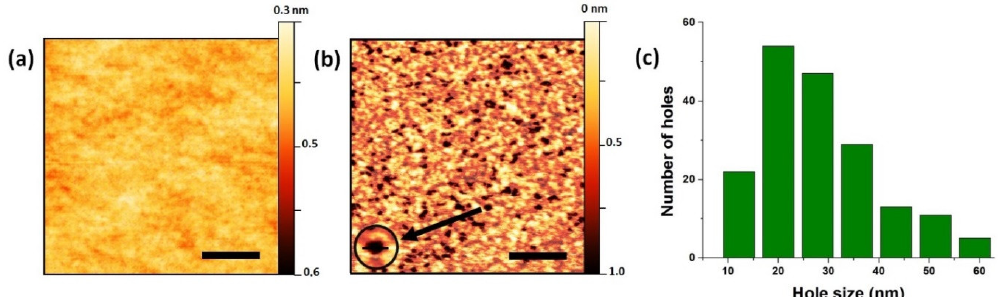
Figure 1. Typical AFM images of SiO x /Si(111) substrate surface: ( a ) initial and ( b ) after In droplets formation, etching, crystallization and evaporation of In from the surface. The scale bar corresponds to 250 nm. The insertion shows AFM image of a single hole in SiO x , which is approximately 35 nm in diameter (scale bar in the insertion corresponds to 50 nm); ( c ) Size distribution of holes in the SiO x layer diagram.